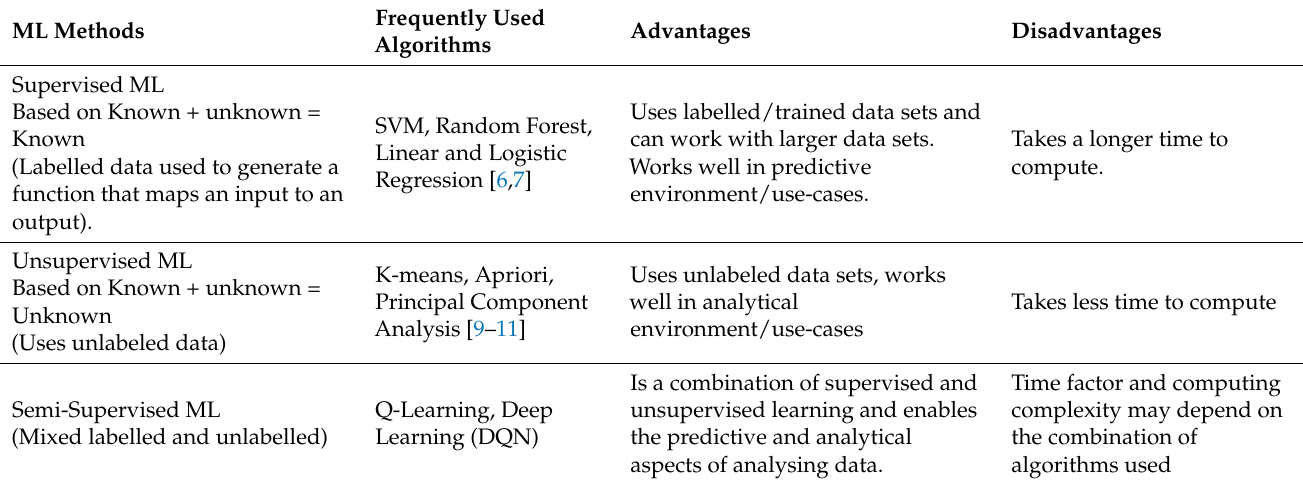
Table 2. Summary of ML Methods—Advantages and